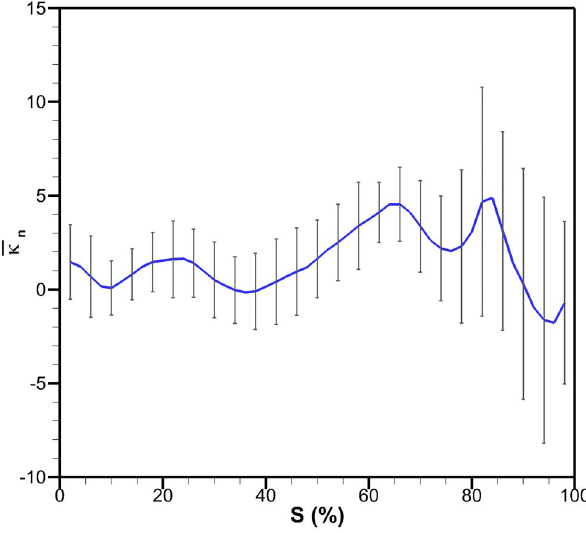
Fig. 8. Exumbrella curvature. Average curvature as a function of exumbrella arclength for two full cycles. The arclength is in percentage of the total relaxed exumbrella arclength. Error bars show the first variance. Peaks and valleys represent potential node